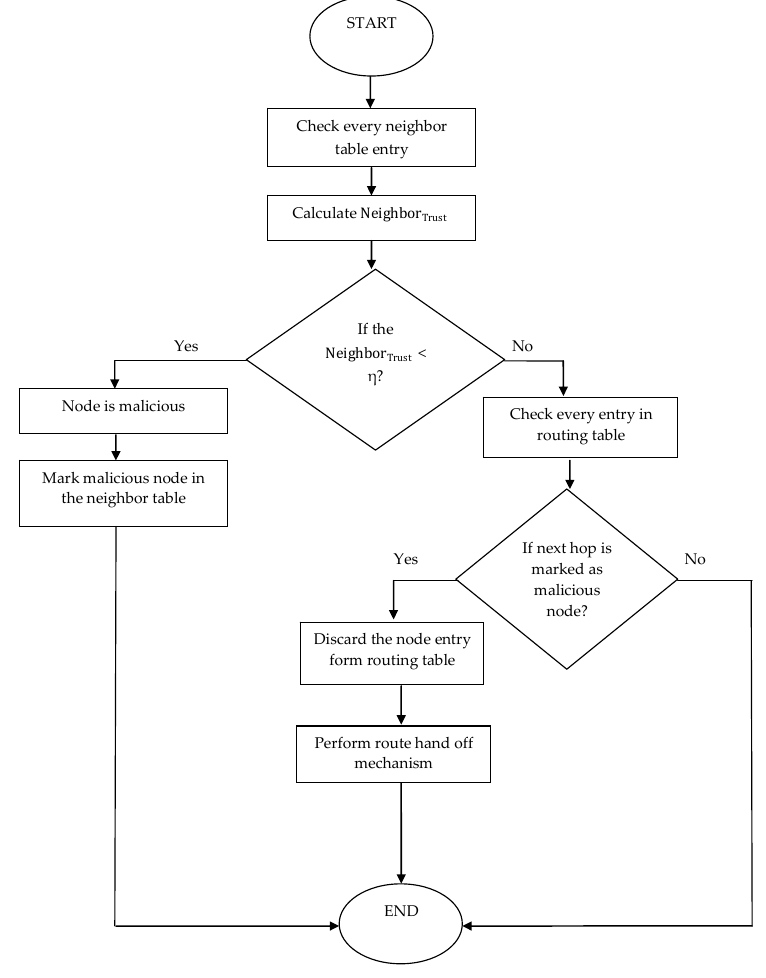
Figure 3. Trust update.